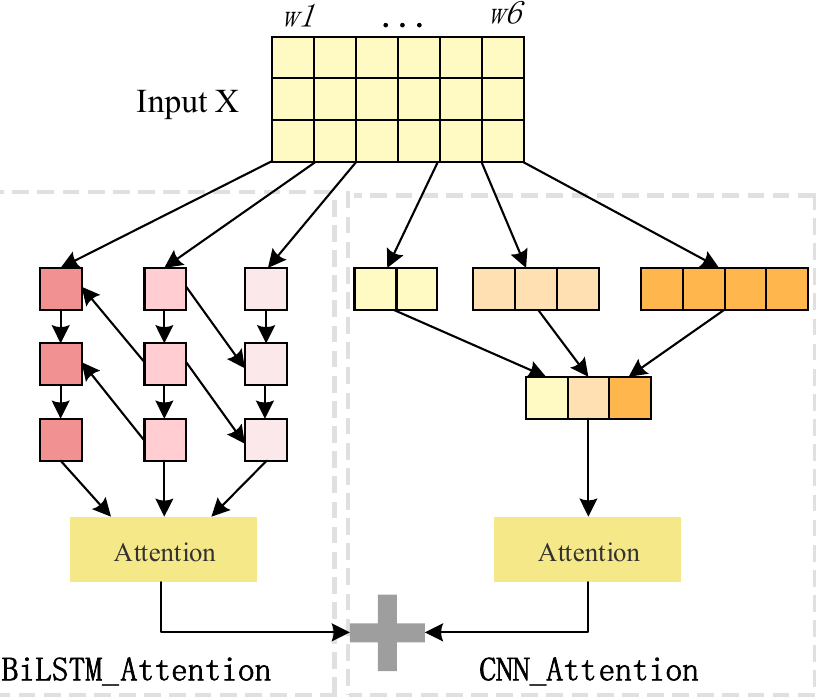
Figure 3. Network structure diagram of textual feature extraction.